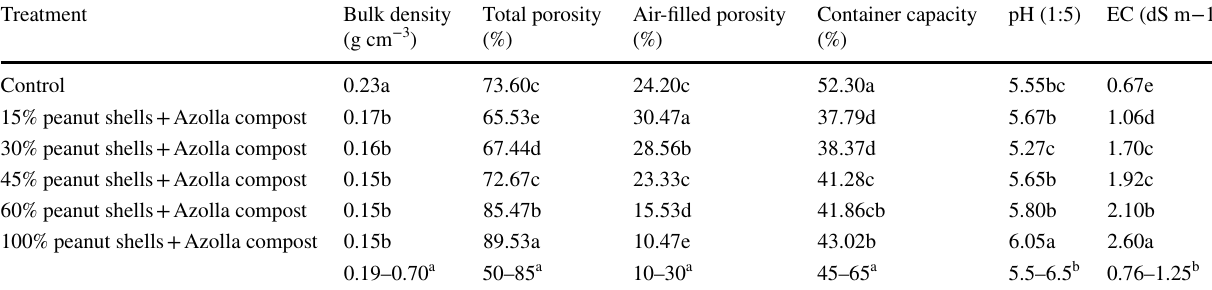
Table 6 Physical characteristics of substrates